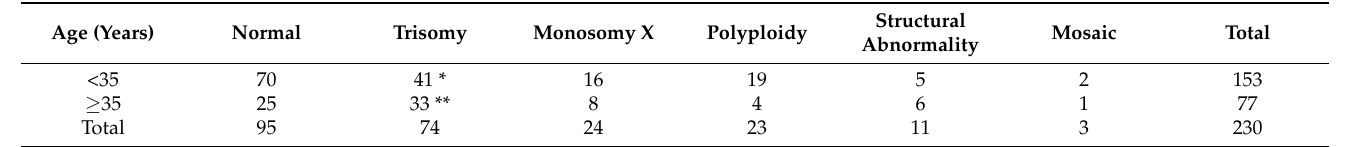
Table 4. Chromosomal abnormalities stratified by maternal